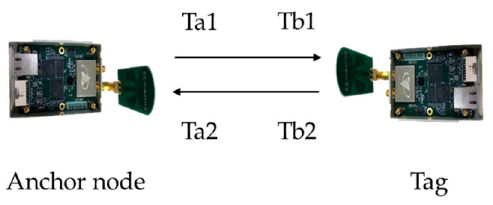
Figure 1. TW-TOF schematic diagram.